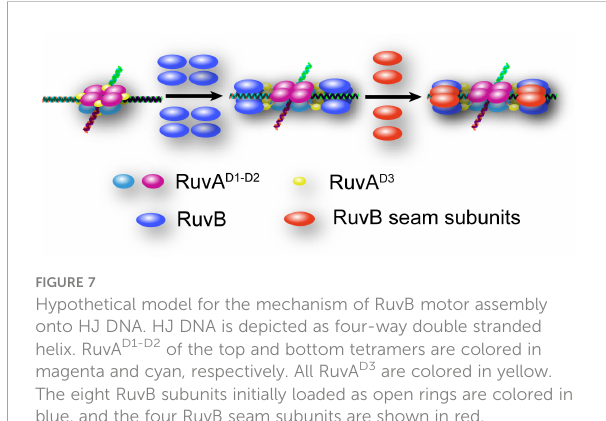
FIGURE 7 Hypothetical model for the mechanism of RuvB motor assembly onto HJ DNA. HJ DNA is depicted as four-way double stranded helix. RuvA D1-D2 of the top and bottom tetramers are colored in magenta and cyan, respectively. All RuvA D3 are colored in yellow. The eight RuvB subunits initially loaded as open rings are colored in blue, and the four RuvB seam subunits are shown in